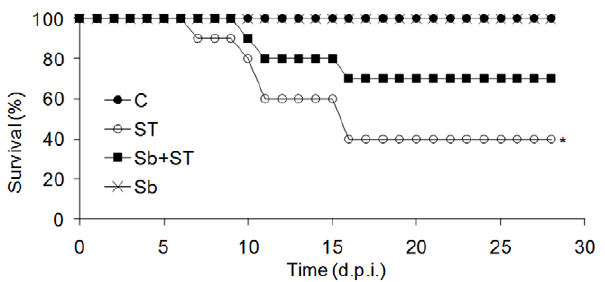
Figure 1. S.boulardii decreases S. Typhimurium induced death of mice. Survival (%) of mice treated daily (Sb + ST) or not (ST) with S. boulardii during 10 days before challenged with 10 4 S. Typhimurium. (C) control (not-treated, not-challenged mice), (Sb) mice treated with S. boulardii without bacterial challenge. N=10. *Indicates statistical difference in relation to control (not treated) group. d.p.i., days post infection.